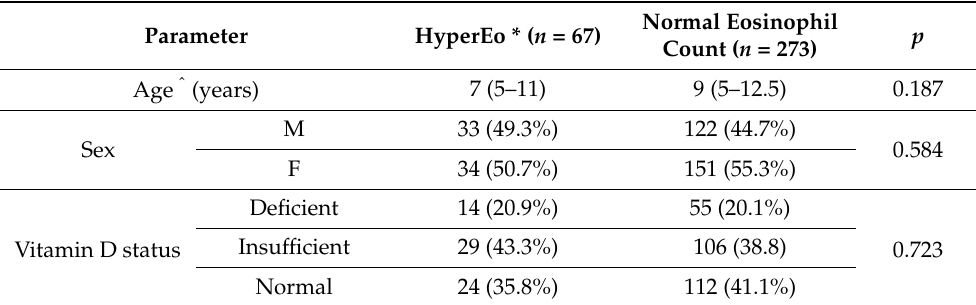
Figure 1. Box plot showing the levels of vitamin D (ng/mL) in children and adolescents with and without atopy ( n = 340). Data are expressed as median, p < 0.064. children are presented in Table 2. Table 2. Hypereosinophilia (HyperEo) according to the age, sex, and vitamin D status of the study children (n = 340).